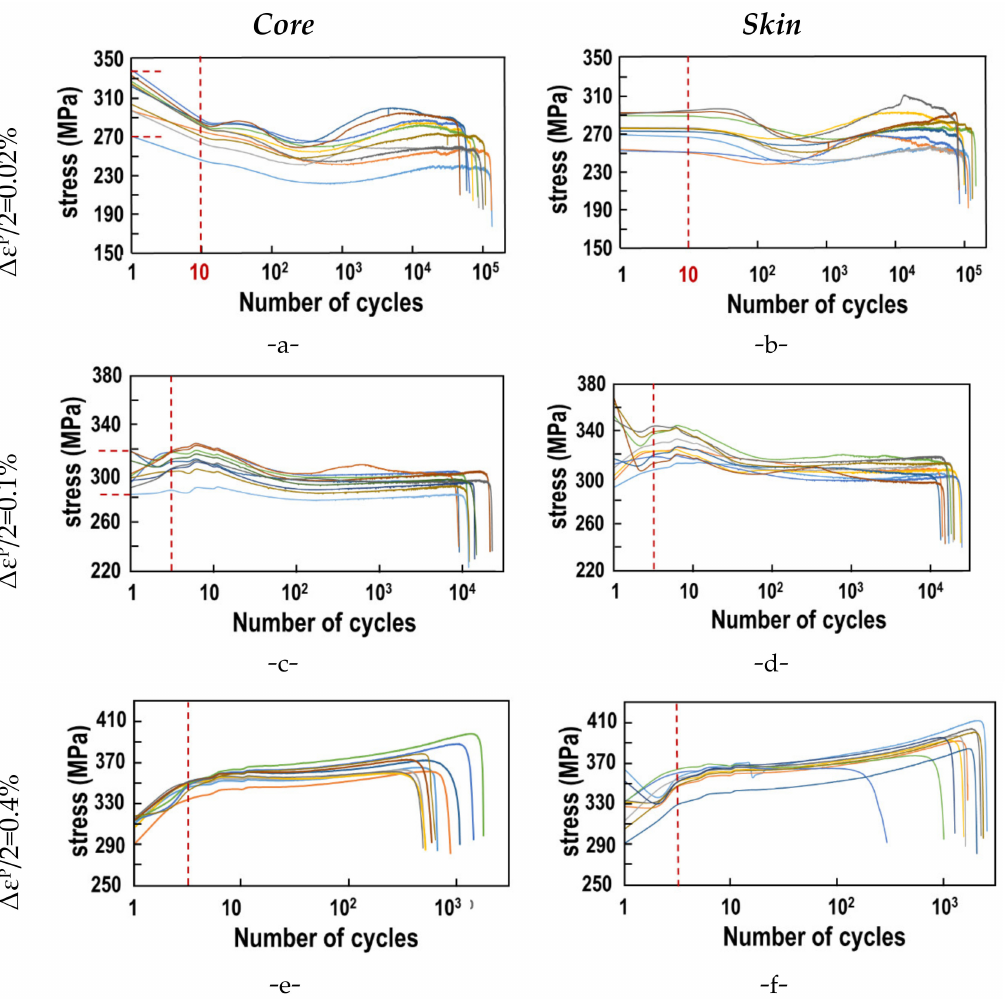
Figure 10. Fatigue test results (stress vs. number of cycles) for different values of plastic strain ∆ ε P /2 = 0.1% ( a , b ); 0.2% ( c , d ) and 0.4% ( e , f ). Samples for the ingot core are represented in ( a , c , e )